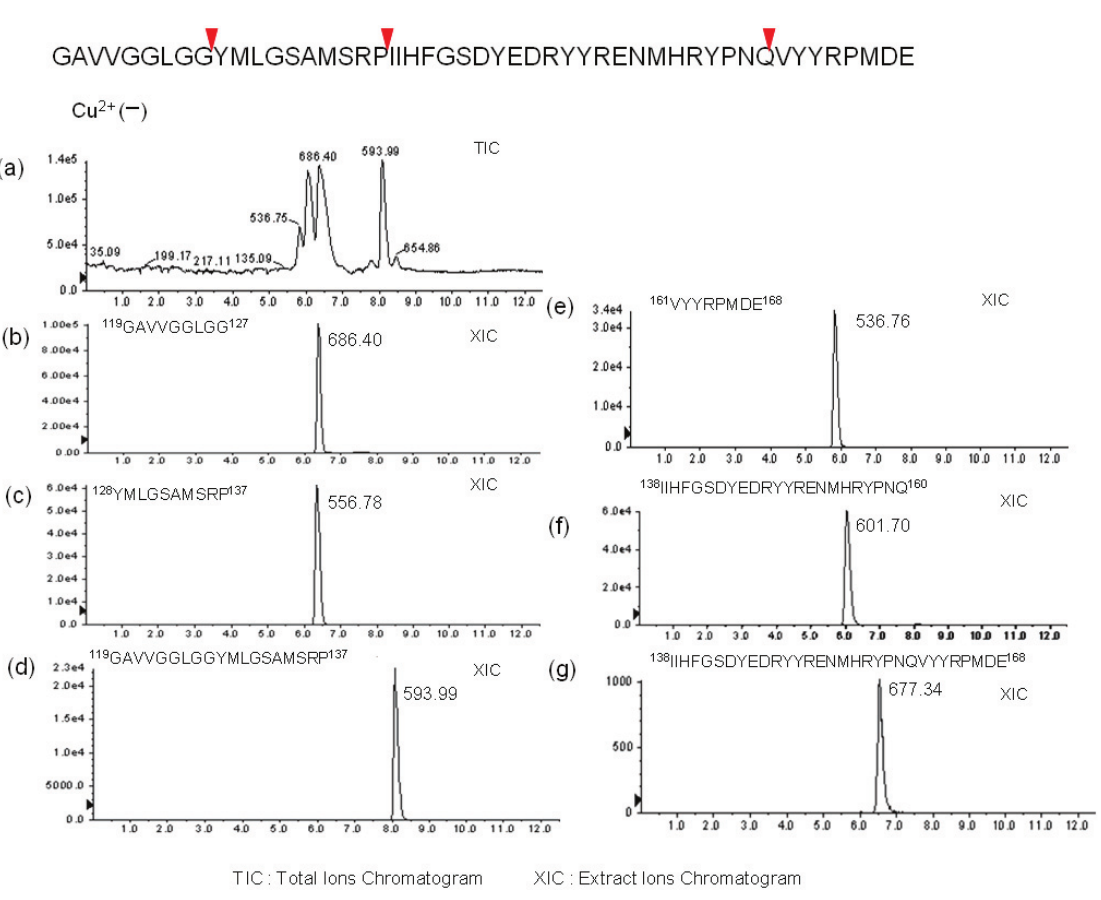
Figure 3. Sequence analysis by LC-ESI-QTOF MS of fragment peptides in the reaction mixture of hPrP119–168 in the absence of Cu 2+ . ( a ) Total ion chromatogram (TIC) of reaction mixture. Extracted ion chromatogram monitored by hPrP119–127 fragment ion ( b ), by hPrP128–137 fragment ion ( c ), by hPrP119–137 fragment ion ( d ), by hPrP161–168 fragment ion ( e ), by hPrP138-160 fragment ion ( f ), by hPrP138-168 fragment ion ( g